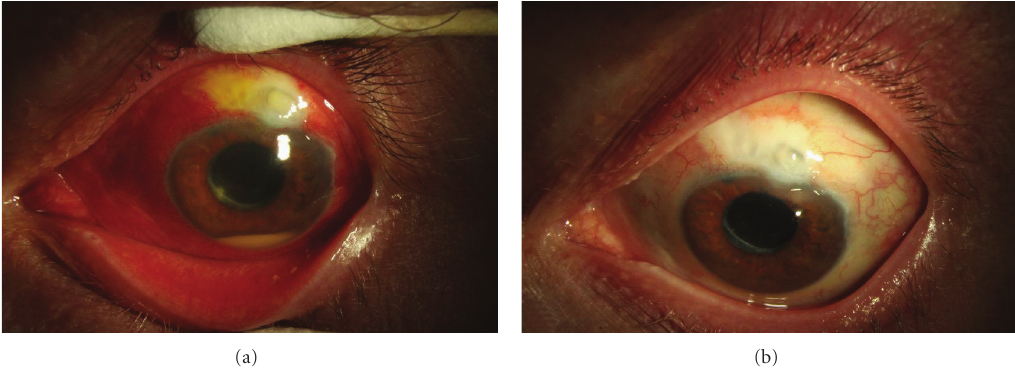
Figure 1: Photographs of the left eye of 55-year-old male presenting with BAE from Moraxella . (a) Presenting VA: HM, IOP: 19mmHg. Treatment: pars plana vitrectomy with intravitreal Vancomycin, Ceftazidime, and Dexamethasone. (b) At 3 months VA: 20/40, IOP: